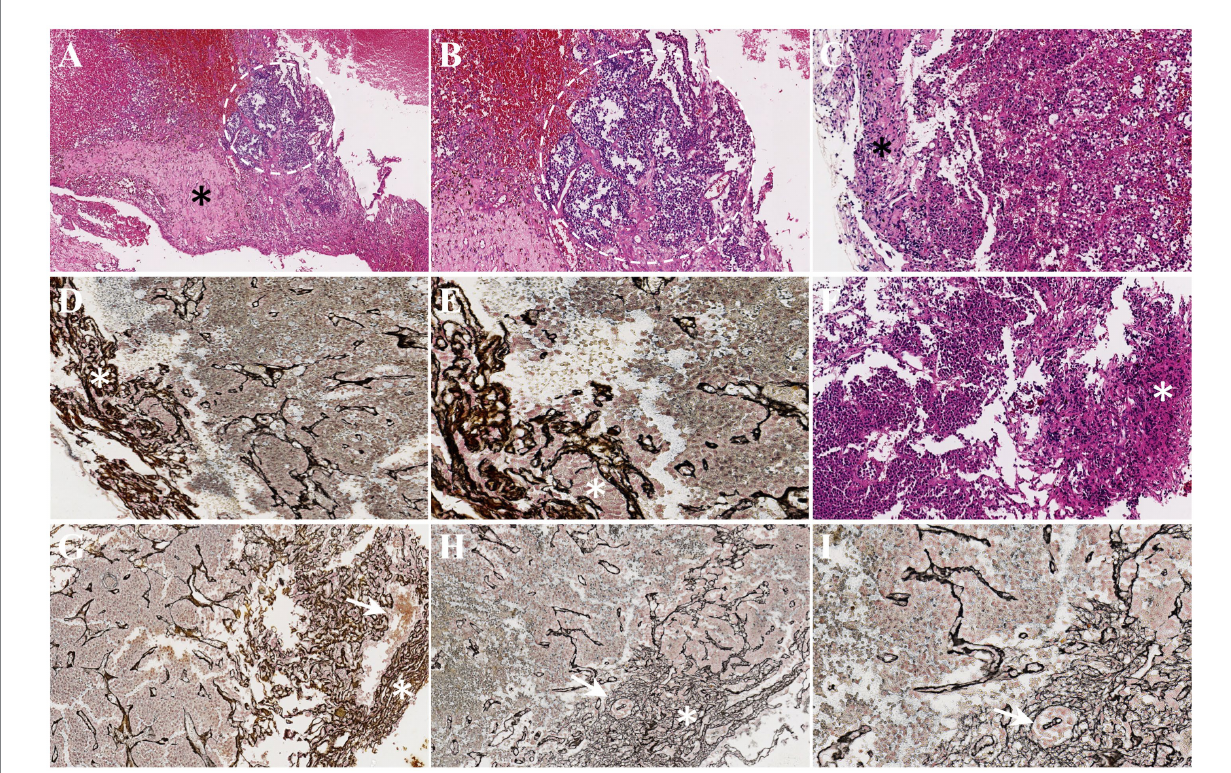
FIGURE 3 Histopathology of pseudocapsules and the suspicious tissues. (A) A thick pseudocapsule (black asterisk) and tumor cell mass (white circle) were detected by H&E staining. (B) With higher magnification, the boundary between the tumor cell mass and the pseudocapsule is unclear. (C) H&E staining indicated a thin connective tissue as a pseudocapsule (black asterisk). (D) Reticulin staining also showed thin pseudocapsule (white asterisk). (E) A higher magnification exhibited the clusters of tumor cells (white asterisk) in the pseudocapsule. (F–I) The fragmentary pseudocapsule (white asterisk) and tumor cells (white arrow) in the suspicious tissues were identified ( F , H&E staining; G–I , reticulin